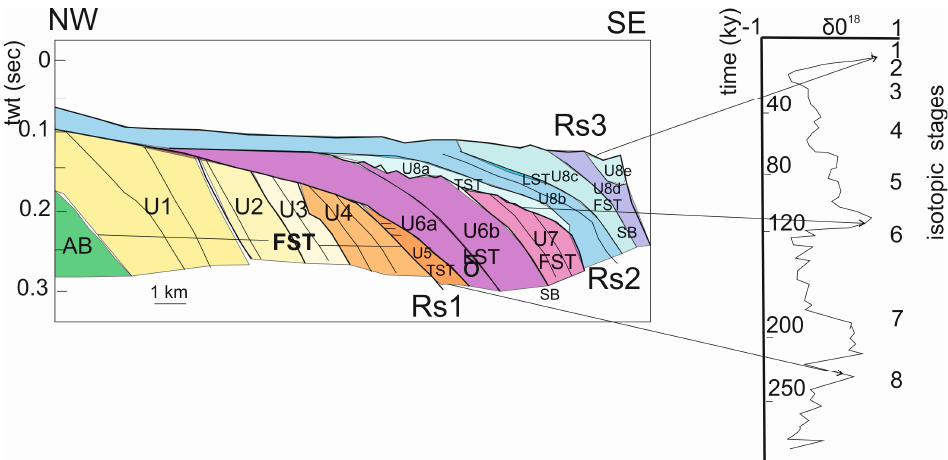
Figure 12. High-resolution stratigraphic correlation between the ravinement surfaces and the seismic units recognized in the Pleistocene succession of the Salento continental shelf and the curve of the oxygen isotopic stratigraphy of the last glacio-eustatic cycle [14], modified after [10]. Sequence stratigraphic interpretation of prograding wedges of W1, W2 and W3 depositional sequences has also been reported.